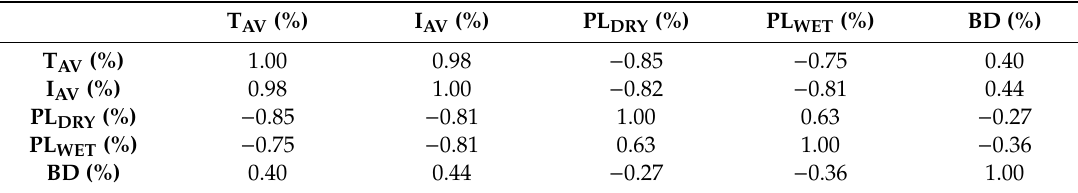
Table 8. Correlation coe ffi cient values between responses.